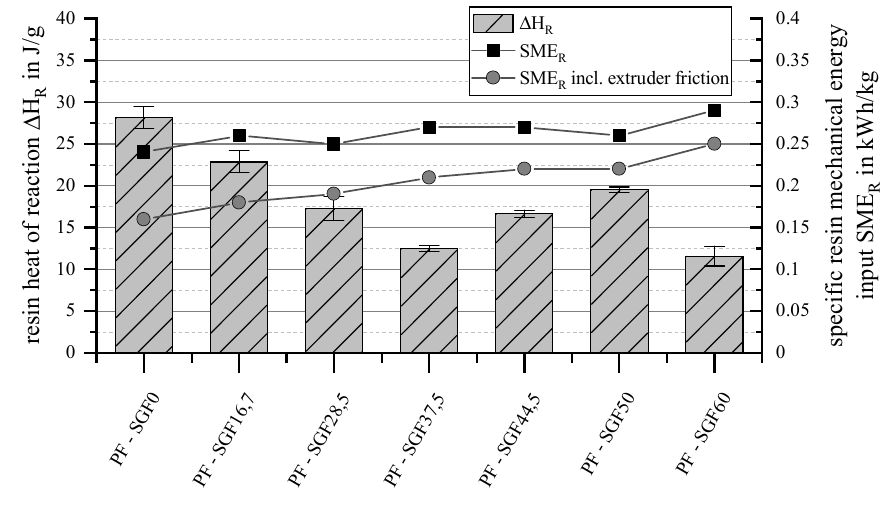
Figure 5. Reaction enthalpy and specific mechanical energy input for the PF-SGF formulations. Low fiber weight contents generally require a higher extruder speed and a lower through- put to keep the SME constant. Nevertheless, its value decreased from SME R = 0.28 kWh/kg for the PF-SGF60 formulation to SME R = 0.24 kWh/kg for PF-SGF0. Since the extruder motor power was used to calculate SME R , this value includes both the energy input to the material and the energy dissipation due to extruder friction. In this context, the extruder friction was defined as the sum of the friction losses in the motor, the gearbox, and between the screws and the barrel. It was determined by operating the extruder at the selected screw speeds for a short time without any molding compound, this means that the gravimetric feeders were switched off. For this reason, a second data series for SME R is shown in Figure 5, considering the extruder friction. With increasing extruder speed, the delta between SME R and SME R including the extruder friction